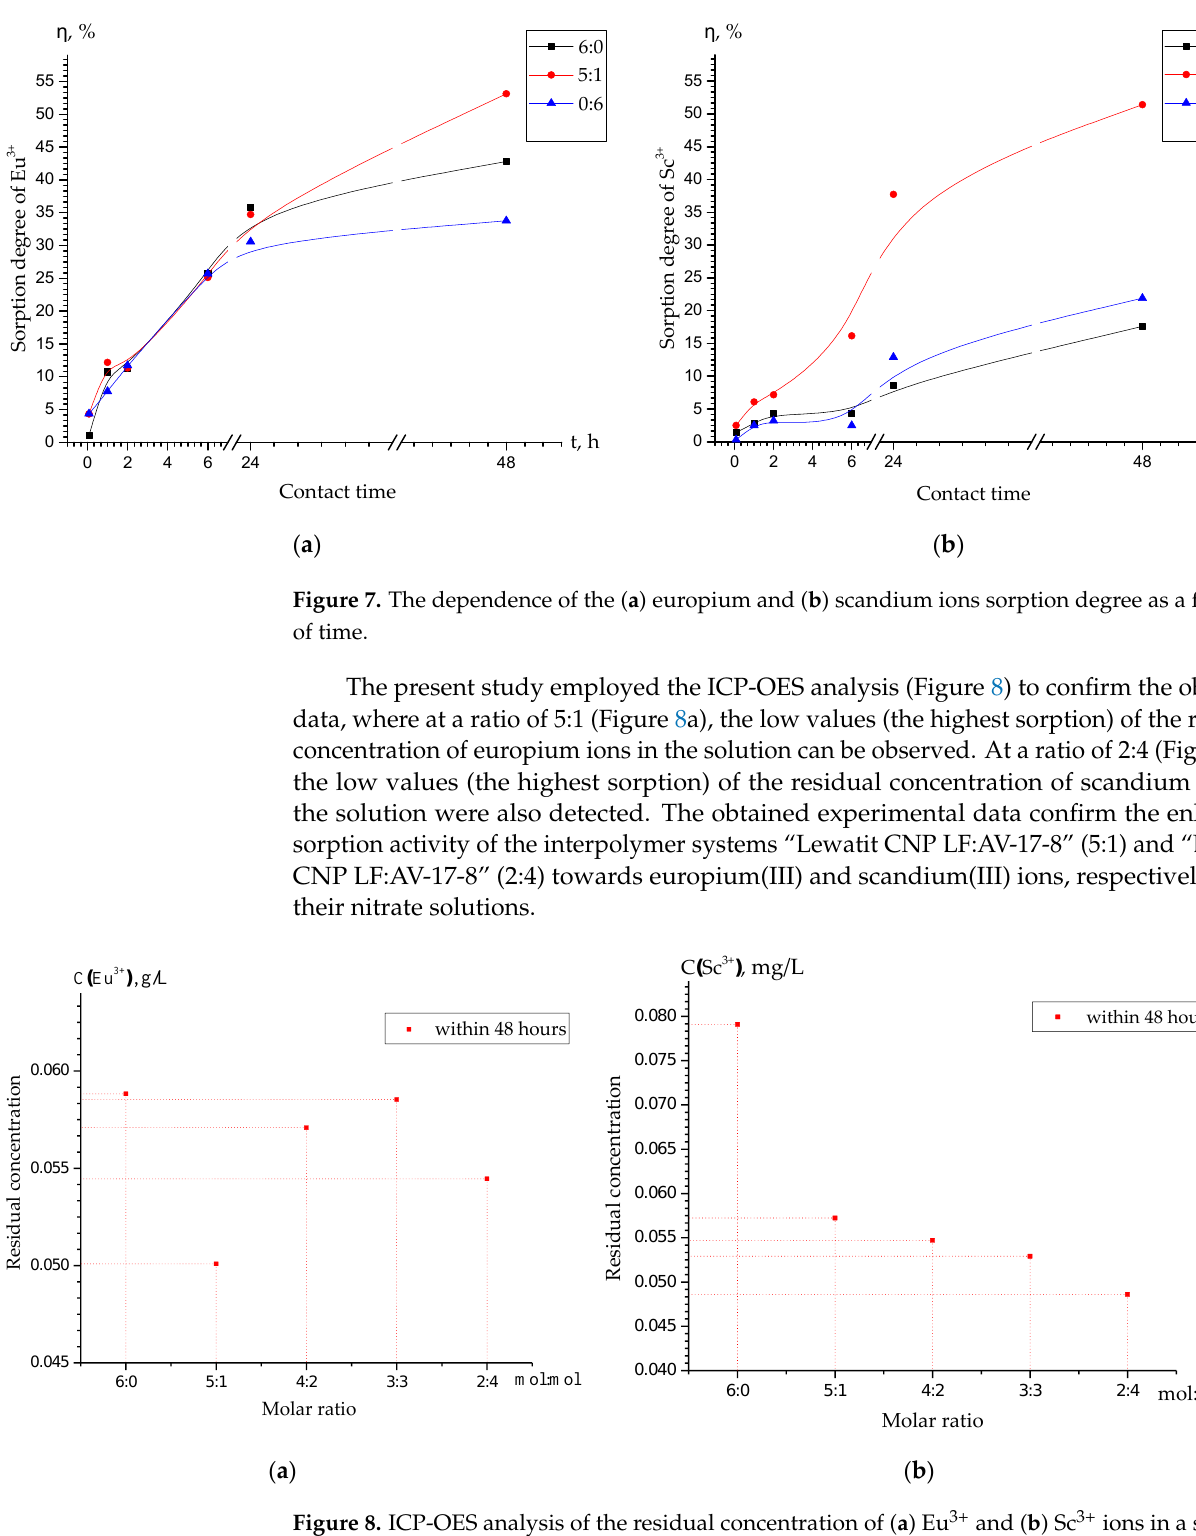
Figure 8. ICP-OES analysis of the residual concentration of ( a ) Eu 3+ and ( b ) Sc 3+ ions in a solution after 48 hours of sorption.